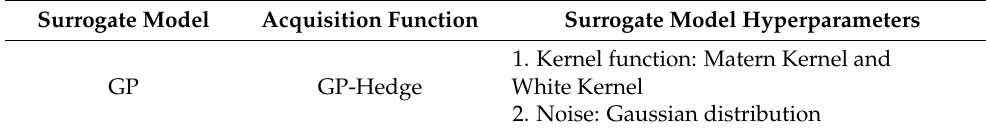
Table 6. The parameters of BO.